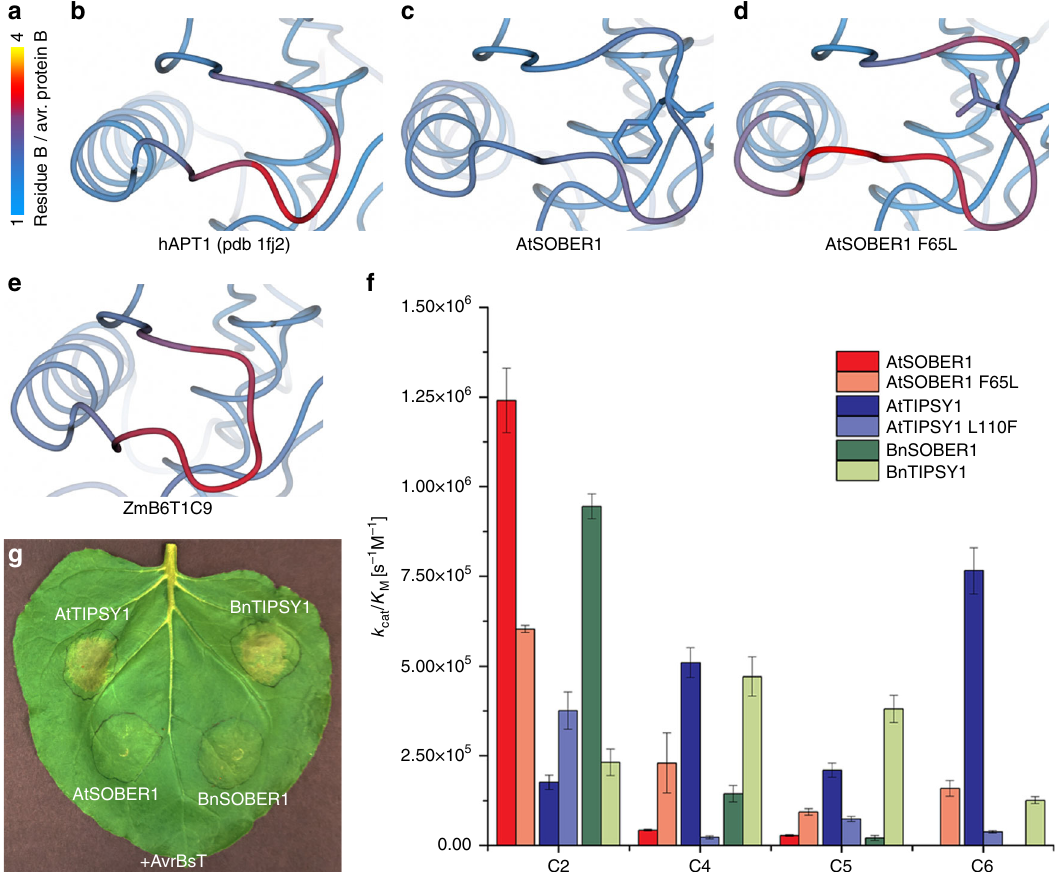
Fig. 5 Enzymatic and biological properties are conserved between AtSOBER1 and BnSOBER1. a – e Lid-loop temperature factors of wild type AtSOBER1, AtSOBER1 F65L and of the acyl-protein thioesterases ZmB6T1C9 and human APT1. f Catalytic ef fi ciencies of wild type and mutant SOBER1/TIPSY1 from Arabidopsis thaliana and Brassica napus on different para -nitrophenyl esters. Data were measured in triplicates and error bars indicate standard deviation. g Transient co-expression of SOBER1/TIPSY1 from Arabidopsis thaliana and B. napus with avrBsT in N.